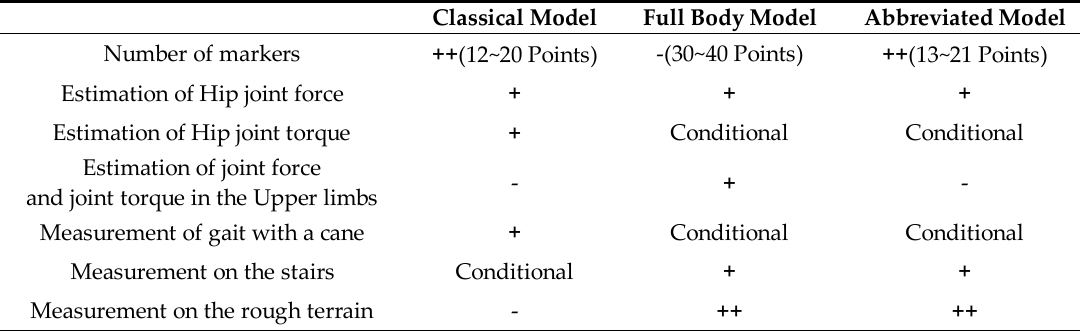
Table 1. Usefulness, availability and pre-requisite of each